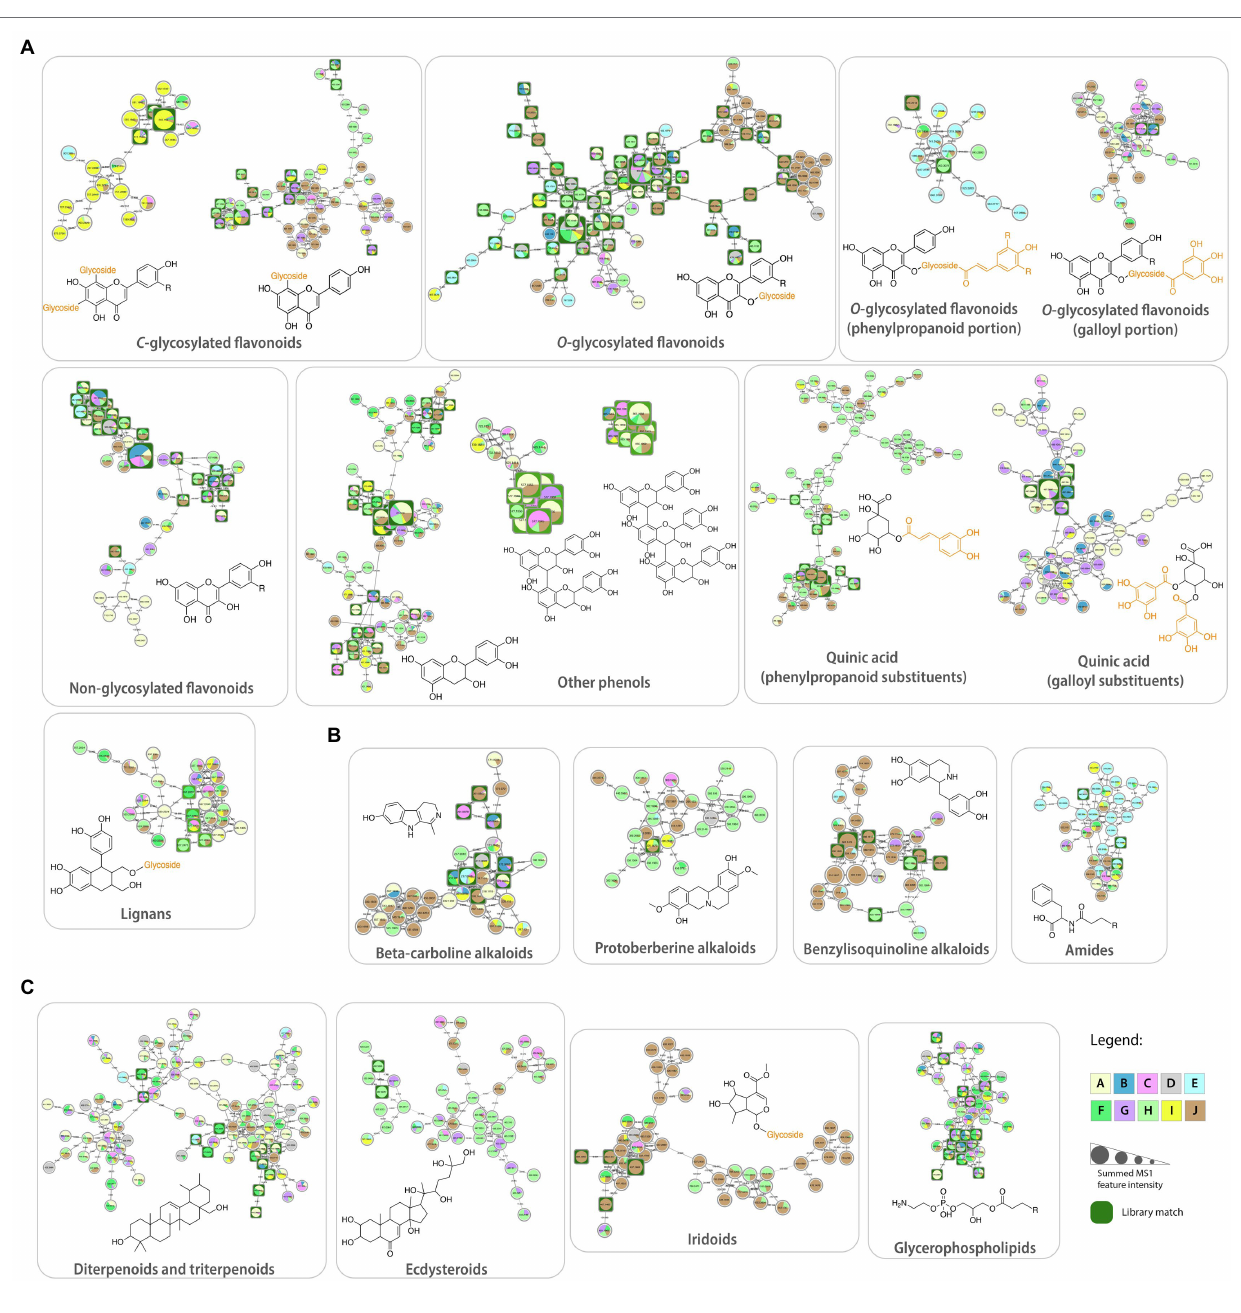
FIGURE 4 | Molecular families obtained from the Feature-Based Molecular Networking workflow and annotated based on spectral matches within the GNPS platform: (A) phenolic compounds, (B) alkaloids, and (C) lipids and terpenoids. Each node represents a tandem mass spectrometry spectra (MS/MS), while the edges that connect them represent the MS/MS fragmentation similarity (cosine >0.7). Pie charts indicate the relative abundance of ion features in each Malpighiaceae phylogenetic clade (A–J). Node sizes are relative to the summed peak areas of the precursor ion in MS1 scans. These are level 2 or 3 annotations according to the 2007 metabolomics standards initiative (Sumner et al.,